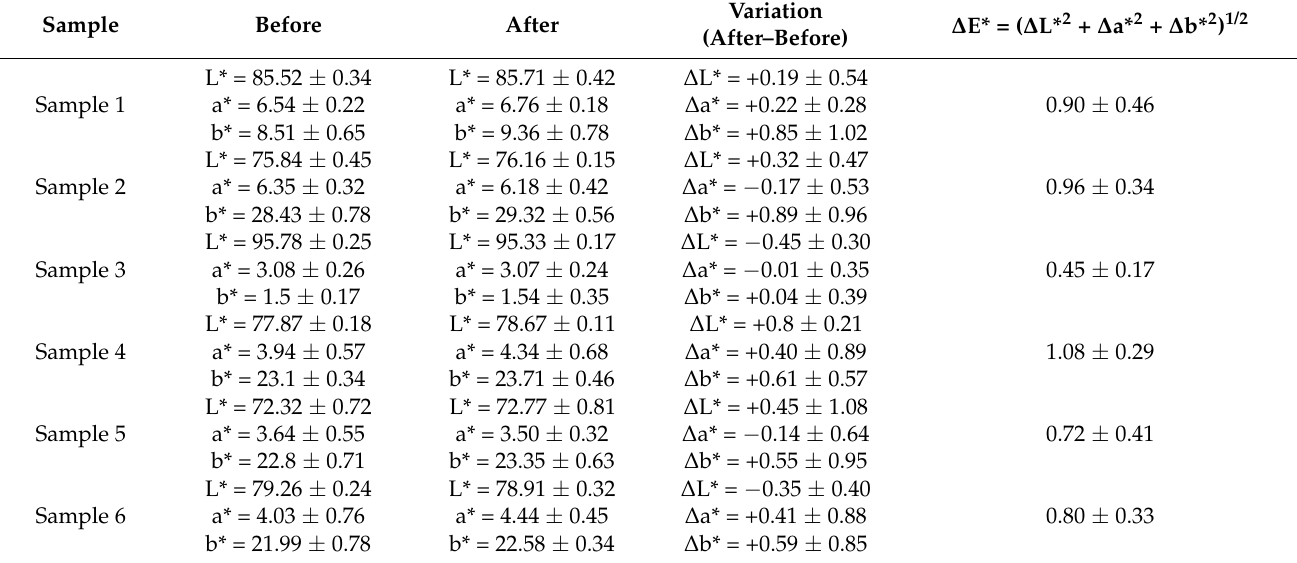
Table 4. Colorimetric coordinates of paper samples before and after EO-Ar